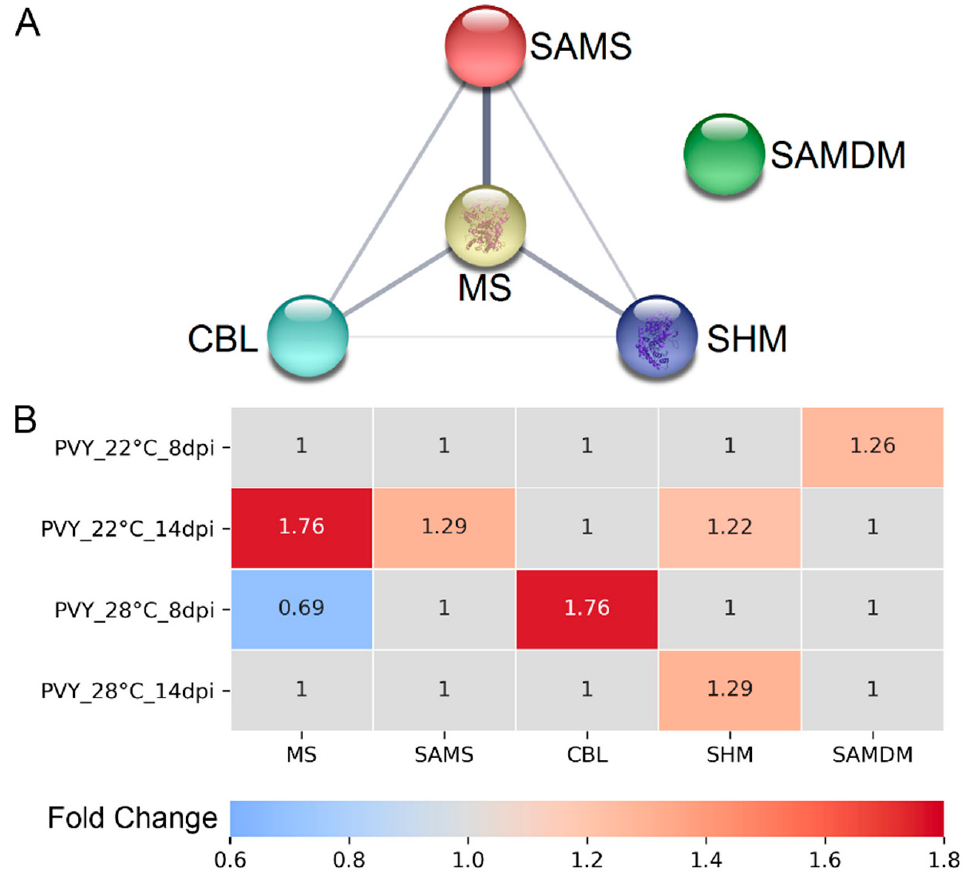
Figure 2. ( A ) Functional protein–protein association network of methionine cycle (MTC)-related differentially expressed proteins (DEPs) in PVY-infected Gala plants at normal and high temperature, constructed using STRING. Proteins are indicated with nodes, and links between proteins are repre- sented by edges. CBL, cystathionine β -lyase; MS, methionine synthase; SAMS, S-adenosyl methionine synthetase; SHM, serine hydroxymethyltransferase; SAMDM, SAM dependent methyltransferase. ( B ) Heatmap showing the changes in abundance of key MTC related enzymes. PVY_22 ◦ C _8dpi, infected Gala plants at 8 dpi at 22 ◦ C; PVY_22 ◦ C _14dpi, infected potato plants at 14 dpi at 22 ◦ C; PVY_28 ◦ C_8 dpi, infected potato plants at 8 dpi at 28 ◦ C; PVY_28 ◦ C _14 dpi, infected potato plants at 14 dpi at 28 ◦